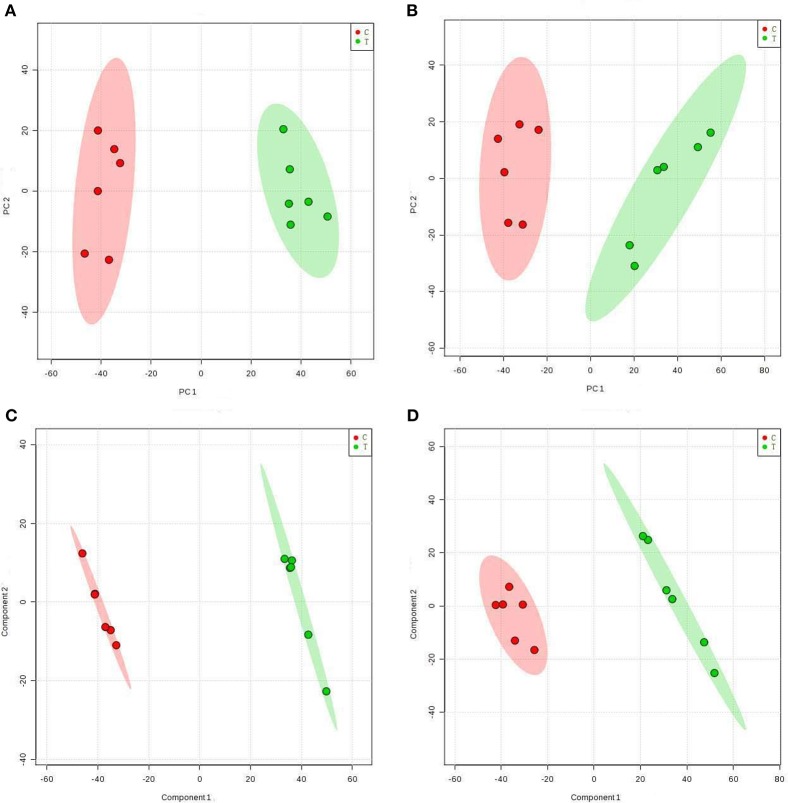
Score plots representing PCA and PLS-DA results based on the UHPLC-Q-TOF MS spectra B. cinerea mycelia from the TTO-treated cells (green dots) and control cells (red dots) are shown in (A,C) positive and (B,D) negative modes. C, control sample; T, TTO-treated sample.